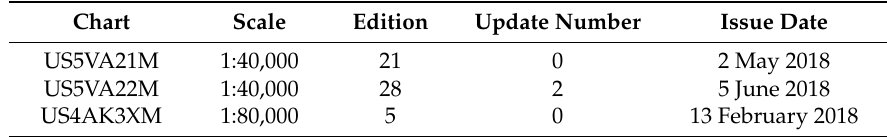
Table 5. Information about the NOAA ENCs used to test the